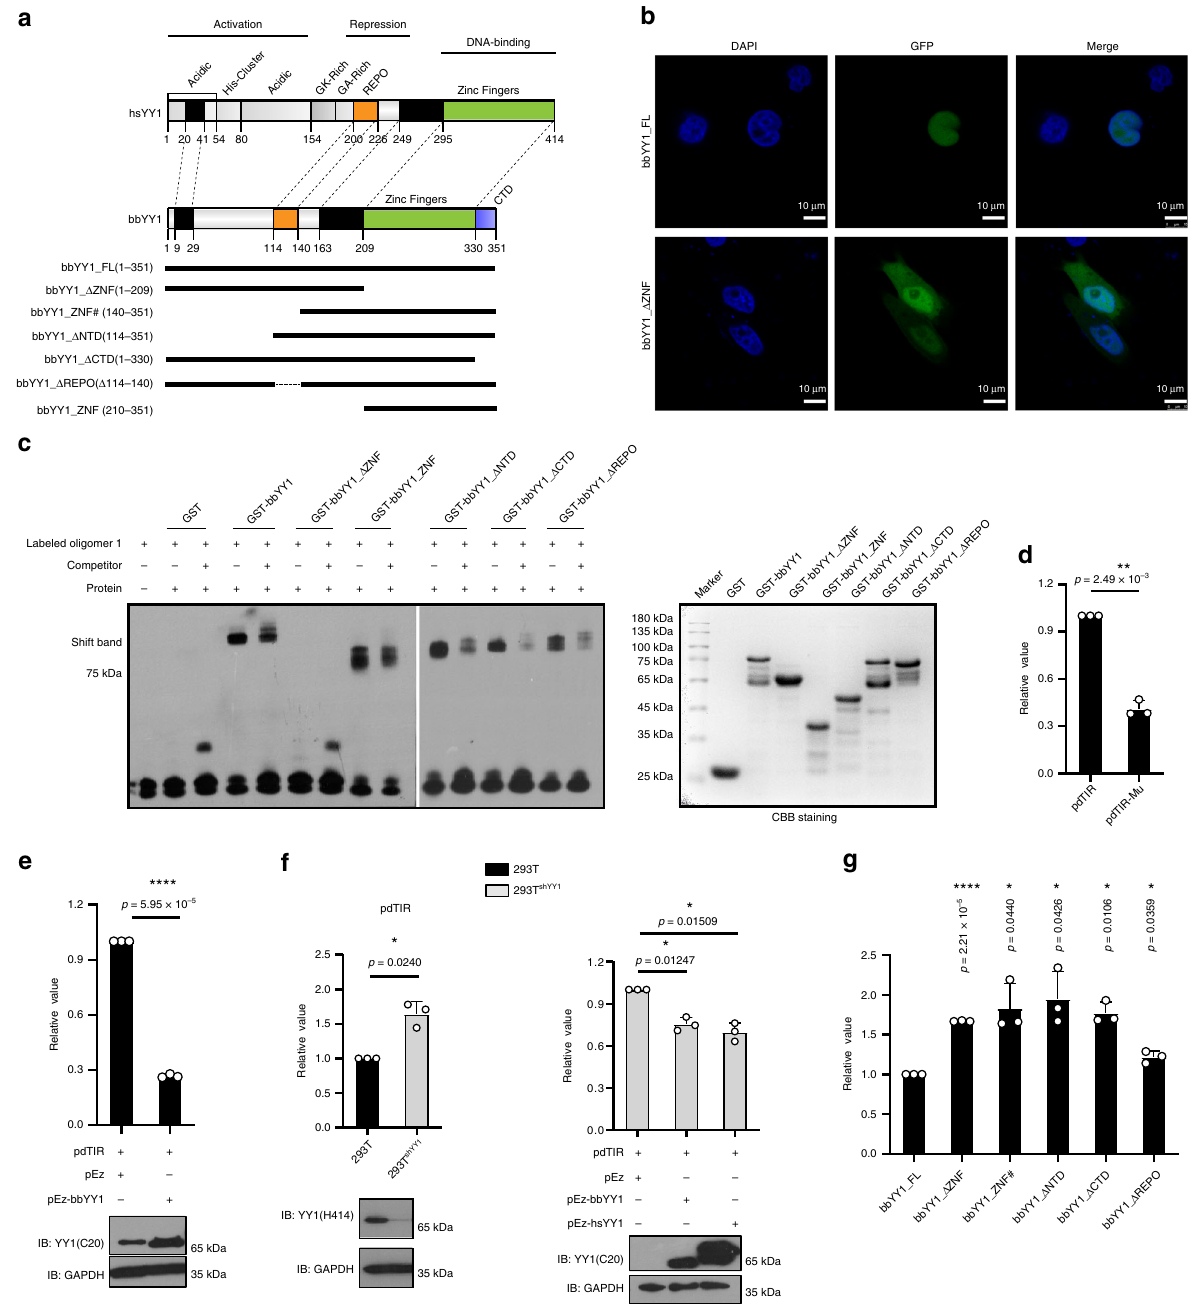
Fig. 2 BbYY1 is involved in ProtoRAG transcription regulation. a Domain architecture of hsYY1 and bbYY1 truncation proteins. b Laser confocal images of bbYY1 and truncates suggested a nuclear location signal in the zinc- fi nger domain (ZNF) of bbYY1. Images display the GFP-tagged bbYY1 and ZNF deleted truncates (bbYY1_ Δ ZNF) in HeLa cells. The displayed image represents two independent experiments with similar results. See also Supplementary Fig. 3A. c Representative EMSAs showed that the ZNF domain was necessary for the binding of bbYY1 truncations to the TIR probe. Left, EMSA gels. Right, SDS- PAGE of GST-tagged bbYY1 truncation proteins. The results are one representative from three independent experiments. d The luciferase reporter assay showed that the mutation of TR5 element on pdTIR decreased the transcription activity. pdTIR-Mu is a construct with a TR5 mutation, as shown in Fig. 1f. e BbYY1 suppresses the transcriptional activity of pdTIR in 293T cells by luciferase reporter assays. Upper, quanti fi cation of transcriptional activities of pdTIR with the expression of bbYY1 in 293T cells. Lower, western blotting of YY1 transfectants. YY1(C20) is a polyclonal antibody that can target both hsYY1 and bbYY1. f Luciferase assays showed that the transcriptional activity of pdTIR was improved with knockdown of hsYY1 in 293T cells, and reduced with overexpression of bbYY1 or hsYY1. IB, immunoblotting. YY1(H414) is a polyclonal antibody targeted to hsYY1. g Luciferase reporter assays showed that each functional domain of bbYY1 was indispensable for the transcriptional inhibition of TIRs. Transcriptional activities were measured by expression quanti fi cation of luciferase by transfection of pdTIR with different bbYY1 truncations into 293T cells. The values of d – g are the means ± s.d., with n = 3 biologically independent experiments. A two-tailed, unpaired Student ’ s t test was used for comparisons. * P < 0.05; ** P < 0.01; *** P < 0.001; **** P < 0.0001. ns, not signi fi cant. For c – g , source data are provided as Source Data fi